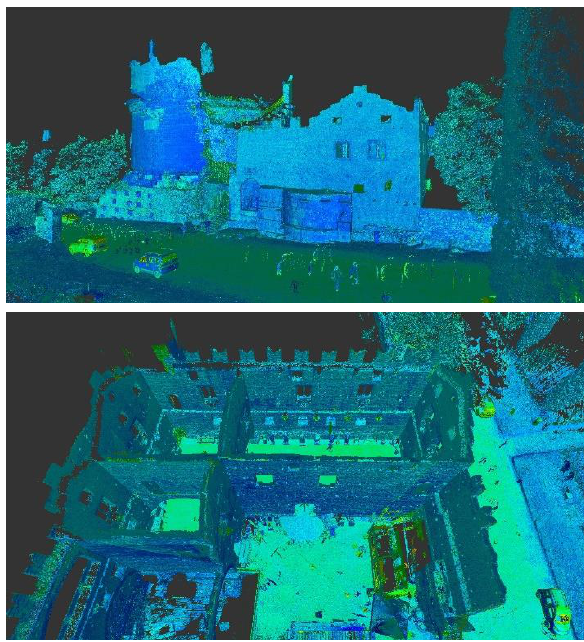
Figure 6. TLS survey data (Top Main Façade, bottom Caetani Castle).